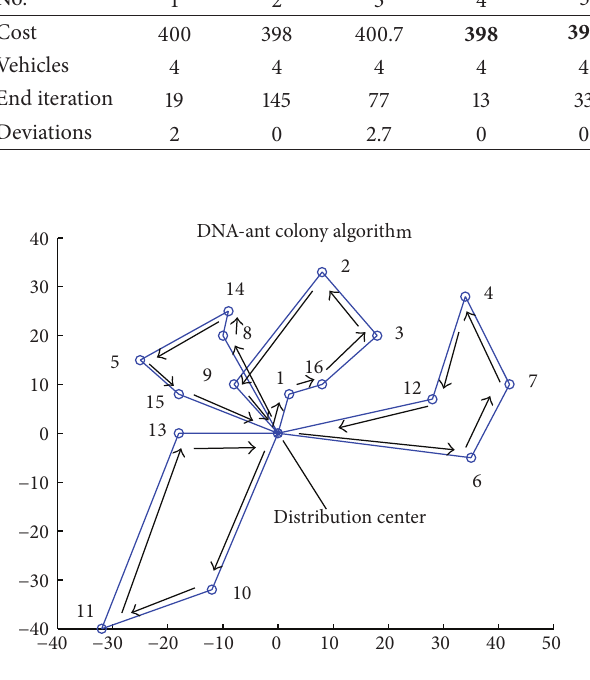
Figure 3: Distribution path DNA-ant colony algorithm (minimum carbon emissions cost).